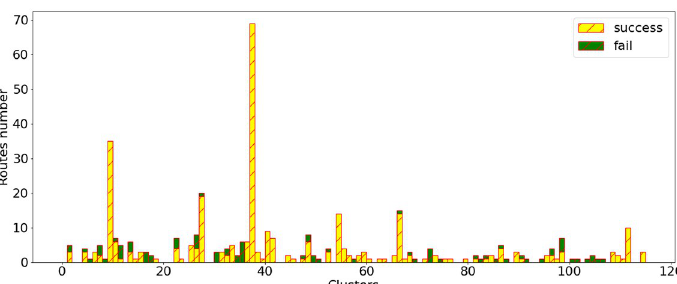
Fig 10. Successed and failed predictions of our LSTM in each cluster in the testing data-set.